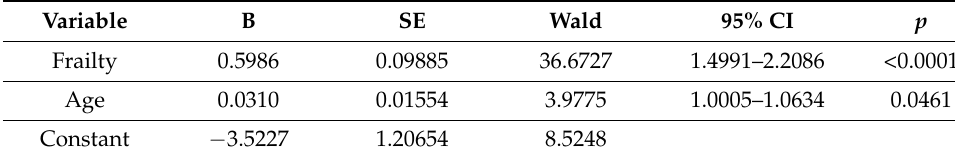
Table 1. Detailed results of logistic regression.